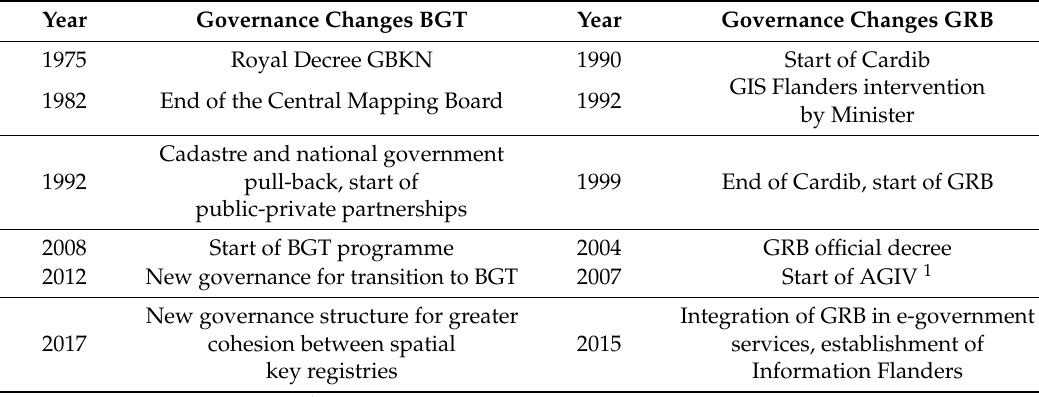
Table 2. Important governance transition moments in the Key Registry Large-Scale Topography (GBKN/BGT) case in The Netherlands and the Large-scale Reference Map (Cardib/GRB) case in Flanders,